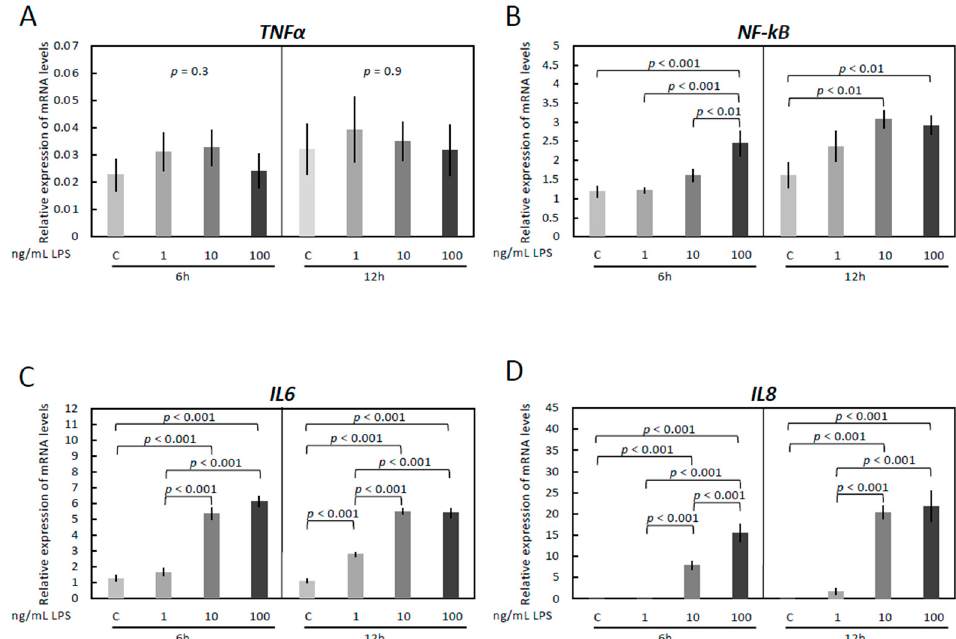
Figure 1. Expression of TNF α ( A ), NF-kB ( B ), IL6 ( C ) and IL8 ( D ) by real-time (TaqMan) PCR after treatment with 0–100 ng/mL LPS for 6 and 12 h. A parametric one-way ANOVA was applied followed by the Tukey–Kramer multiple comparisons post-test. All numerical data are presented as the means ± S.D. p -values < 0.05 were considered significant and are indicated.